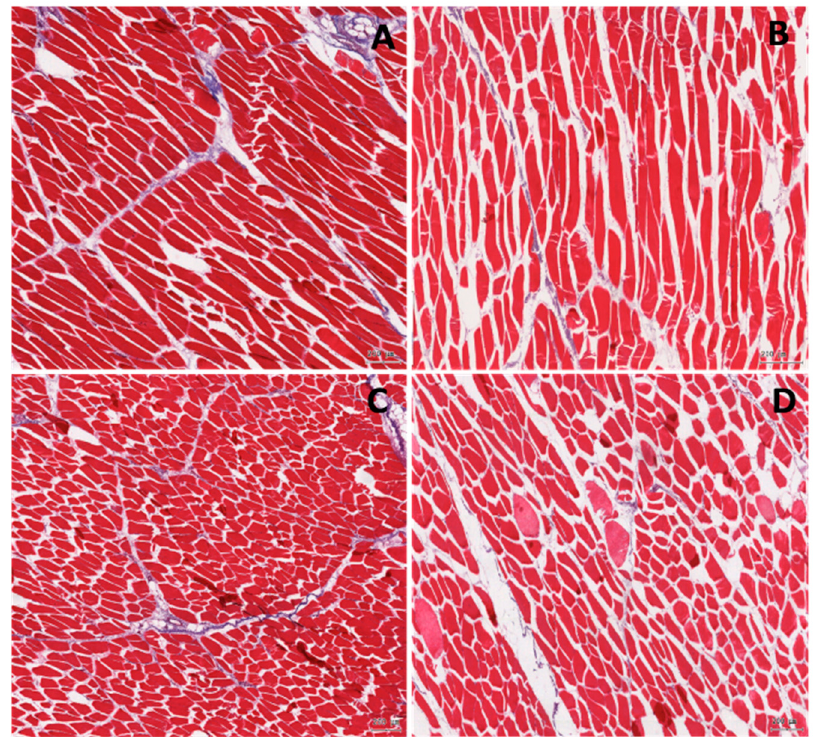
Figure 1. Histological analysis of the muscle in the normal ( A,C ) and the intrauterine growth restricted, IUGR ( B,D ) pigs. Longitudinal ( A,B ) and transverse ( C,D ) section. In the IUGR muscle, the empty spaces between the muscle cells are significantly larger. Distinctly more gain muscles are observed in the IUGR samples.